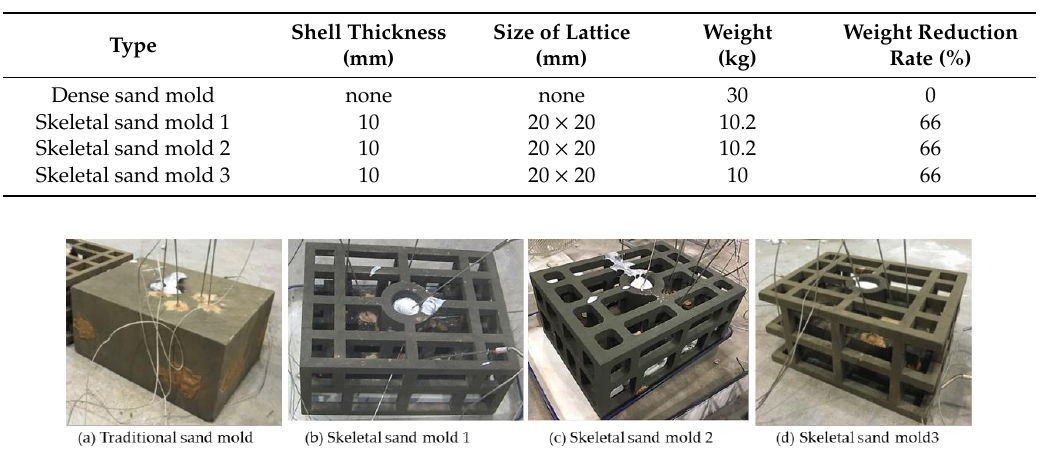
Figure 27. Onsite pouring experiments.